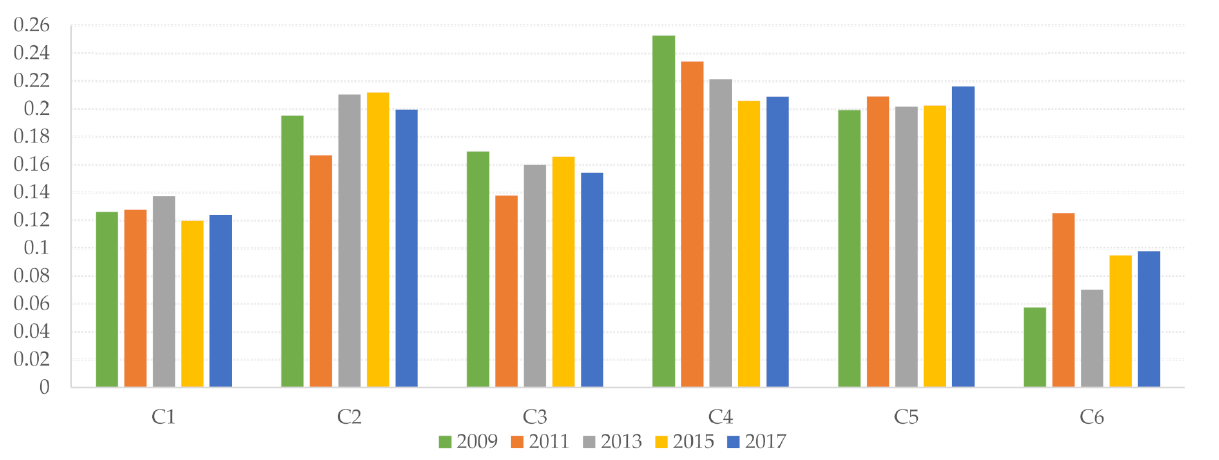
Figure 3. The first-level indicators’ entropy weights from 2009 to